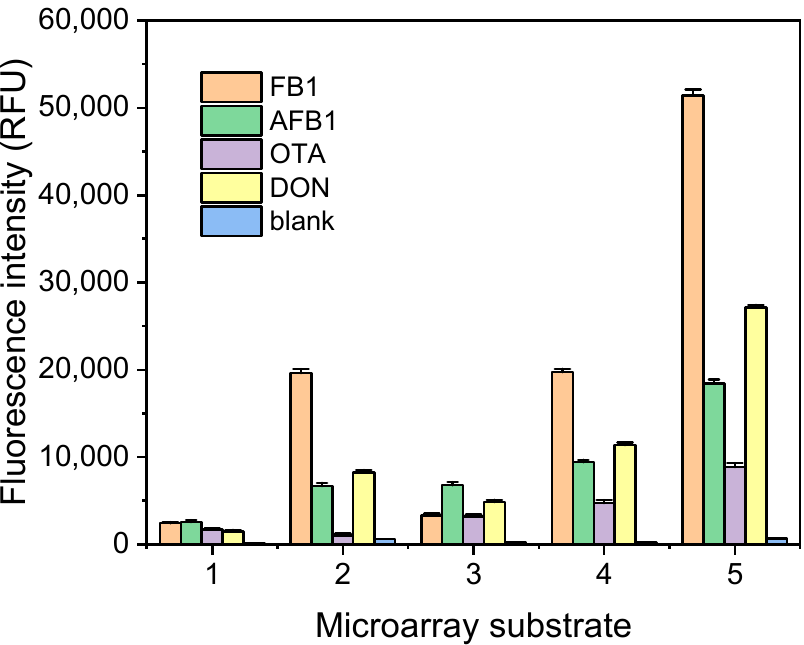
Figure 4. Fluorescence intensity values corresponding to zero calibrators of each one of the four targeted mycotoxins obtained with (3-aminopropyl)triethoxysilane(APTES)-modified glass slides (column set 1), APTES-modified/Ag plated glass slides (column set 2), flat PMMA slides (column set 3), 3D micro-nanostructured PMMA slides (column set 4) and 3D micro-nanostructured/Ag plated PMMA slides (column set 5). The column designation is as follows: orange FB1; green AFB1; purple OTA; yellow DON; blue blank. Each value is the mean of 16 spots ± SD.